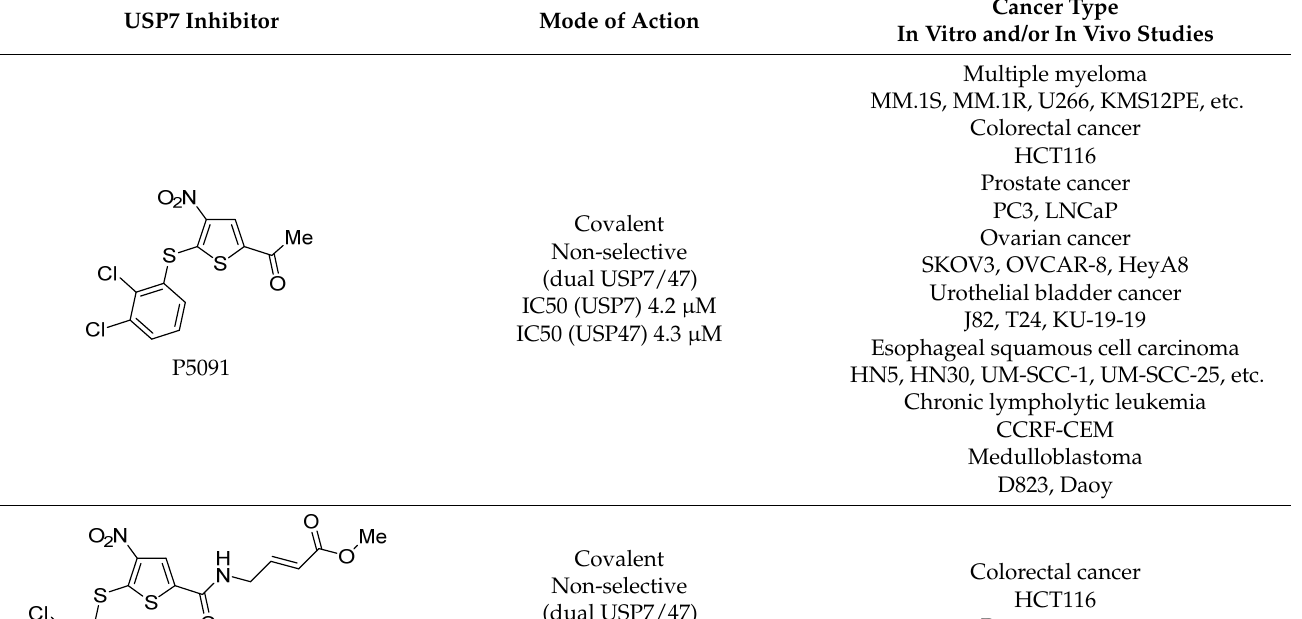
Table 1. Biological properties of the selected USP7 inhibitors with demonstrated effect on anti-tumor immune response.